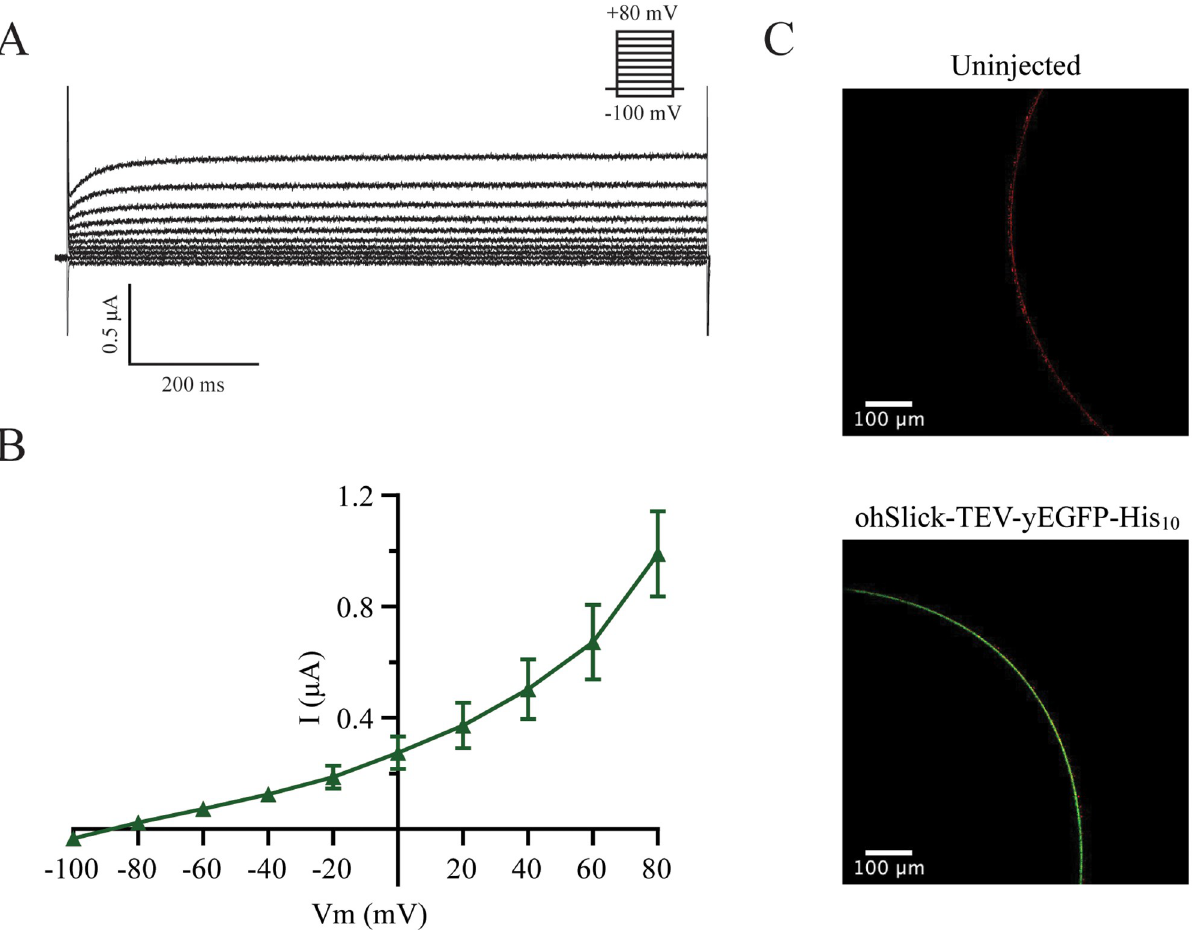
Fig 8. Expression of ohSlick-TEV-yEGFP-His 10 in Xenopus laevis oocytes. (A) Representative traces of ohSlick-TEV-yEGFP-His 10 expressed and measured in Xenopus laevis oocytes 5 days after injection of 25 ng of polyA RNA in vitro transcribed from pXOOY. (B) I-V relation of ohSlick-TEV- yEGFP-His 10 shown as the average ± S.E.M (n = 11). (C) Representative confocal images of oocytes incubated with FM 4–64. The upper image shows an uninjected control oocyte, and the lower image shows an oocyte expressing ohSlick-TEV-yEGFP-His 10 , which colocalizes with the FM4-64 dye.